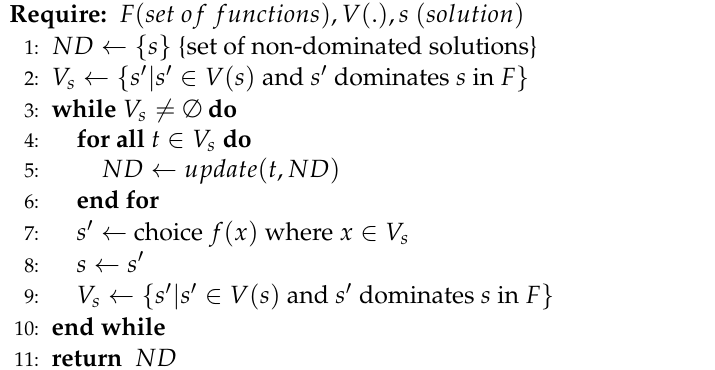
Algorithm 4 Multi-objective local search